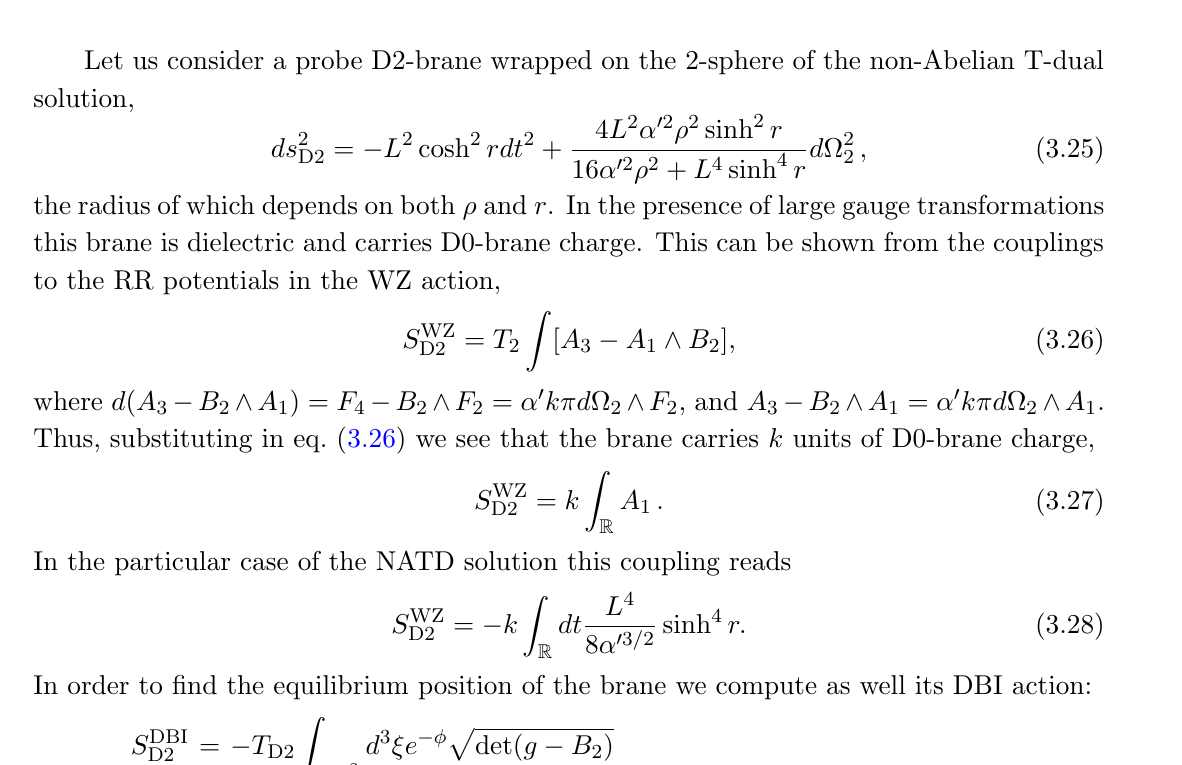
Figure 4 . Young tableaux for the partition (left) and dual partition (right) of